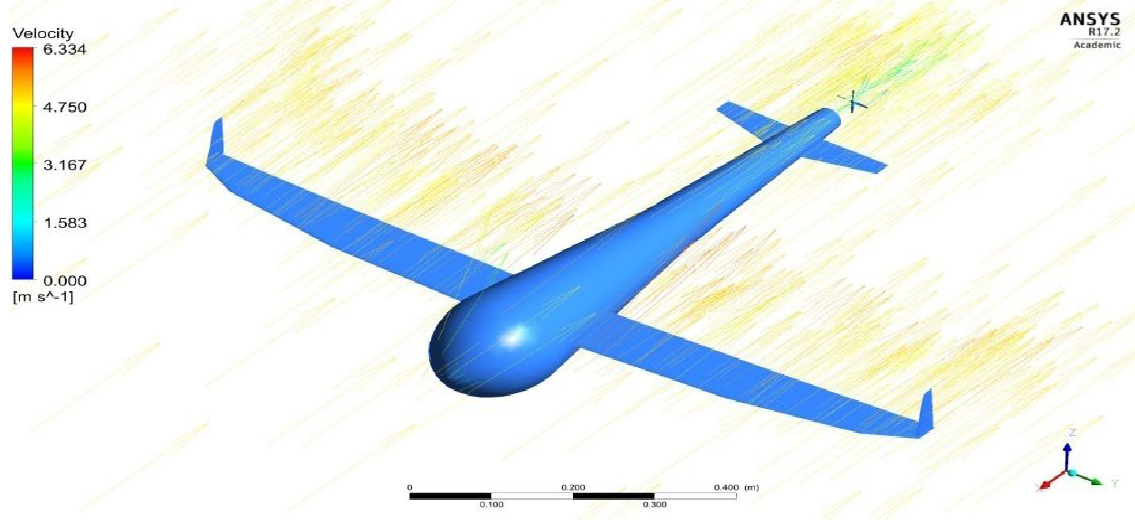
Figure 23. Velocity variations over the UAV.